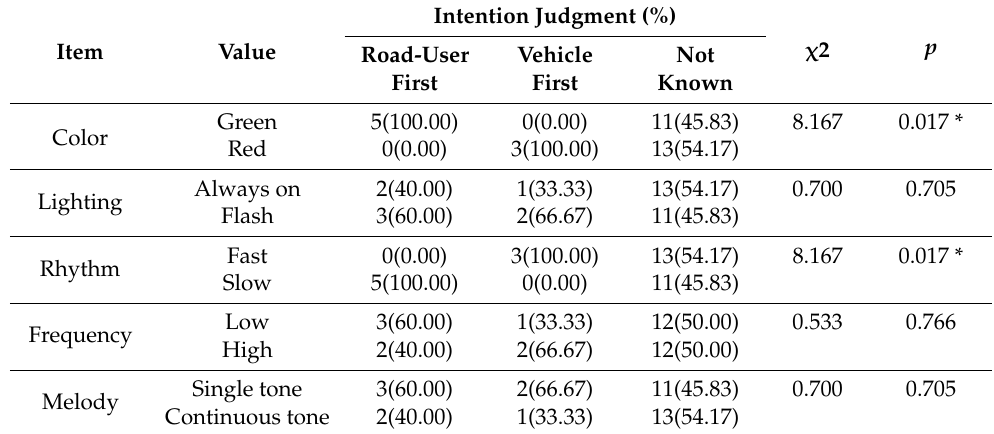
Intention Judgment (%)